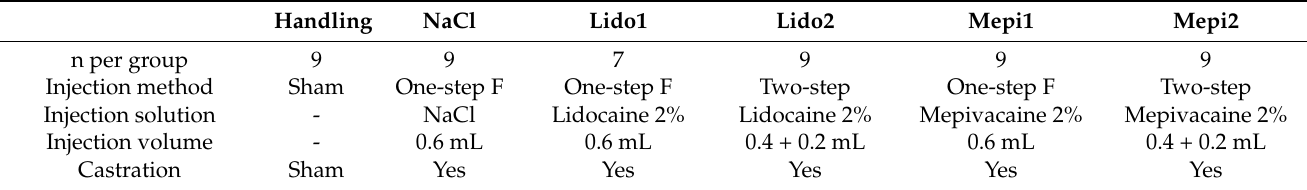
Table 2. Classification of study